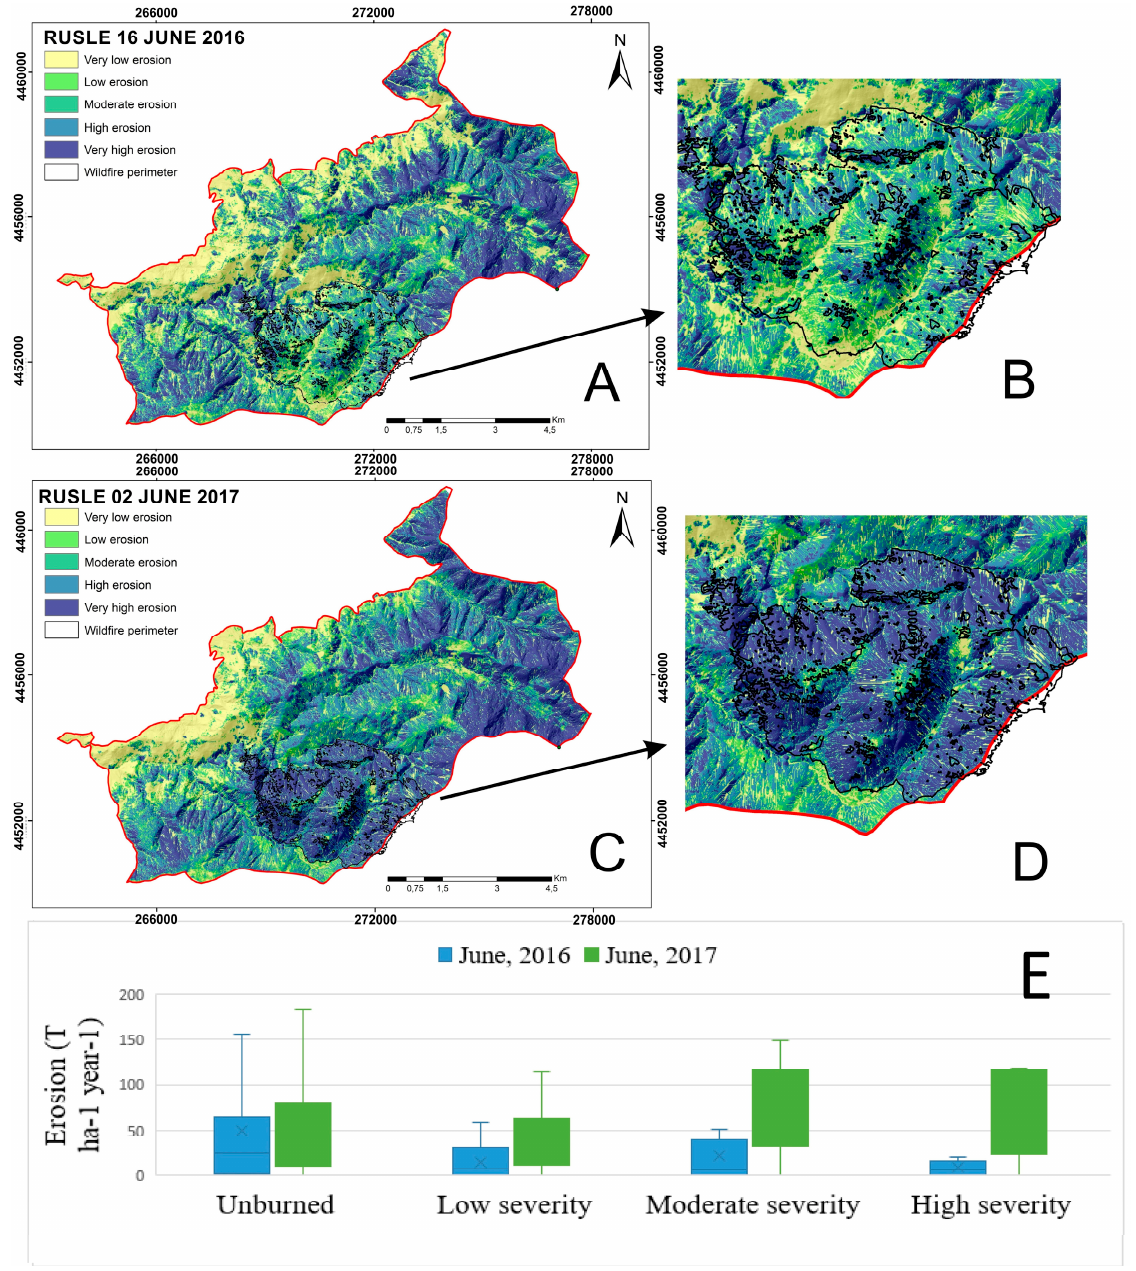
Figure 5. ( A ) Erosion map 16 June 2016; ( B ) Zoom of erosion map in forest fire area 16 June 2016; ( C ) Erosion map 02 June 2017; ( D ) Zoom of erosion map in forest fire area 02 June 2017; ( E ) Comparative graph of the erosion in the different months by area of forest fire severity.